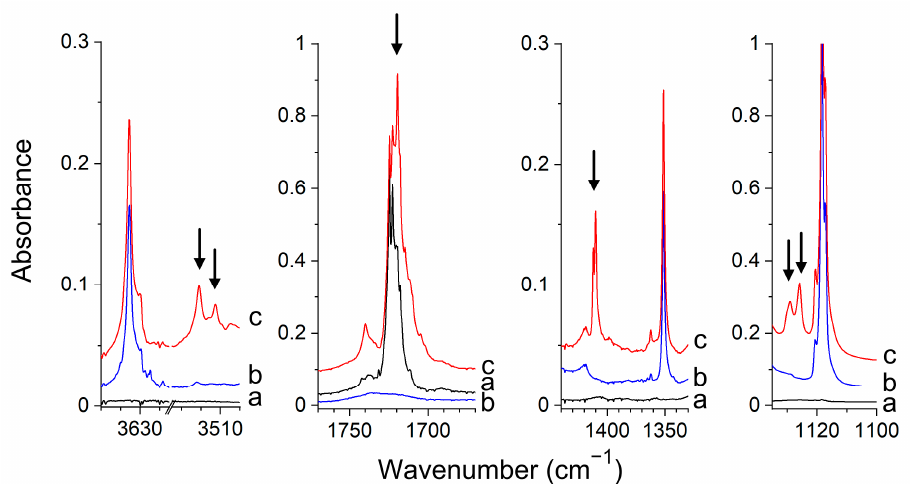
Figure 4. The spectra of the CHOCHO/Ar ( a ), NH 2 OH/Ar ( b ) and CHOCHO/NH 2 OH/Ar ( c ) ma ‐